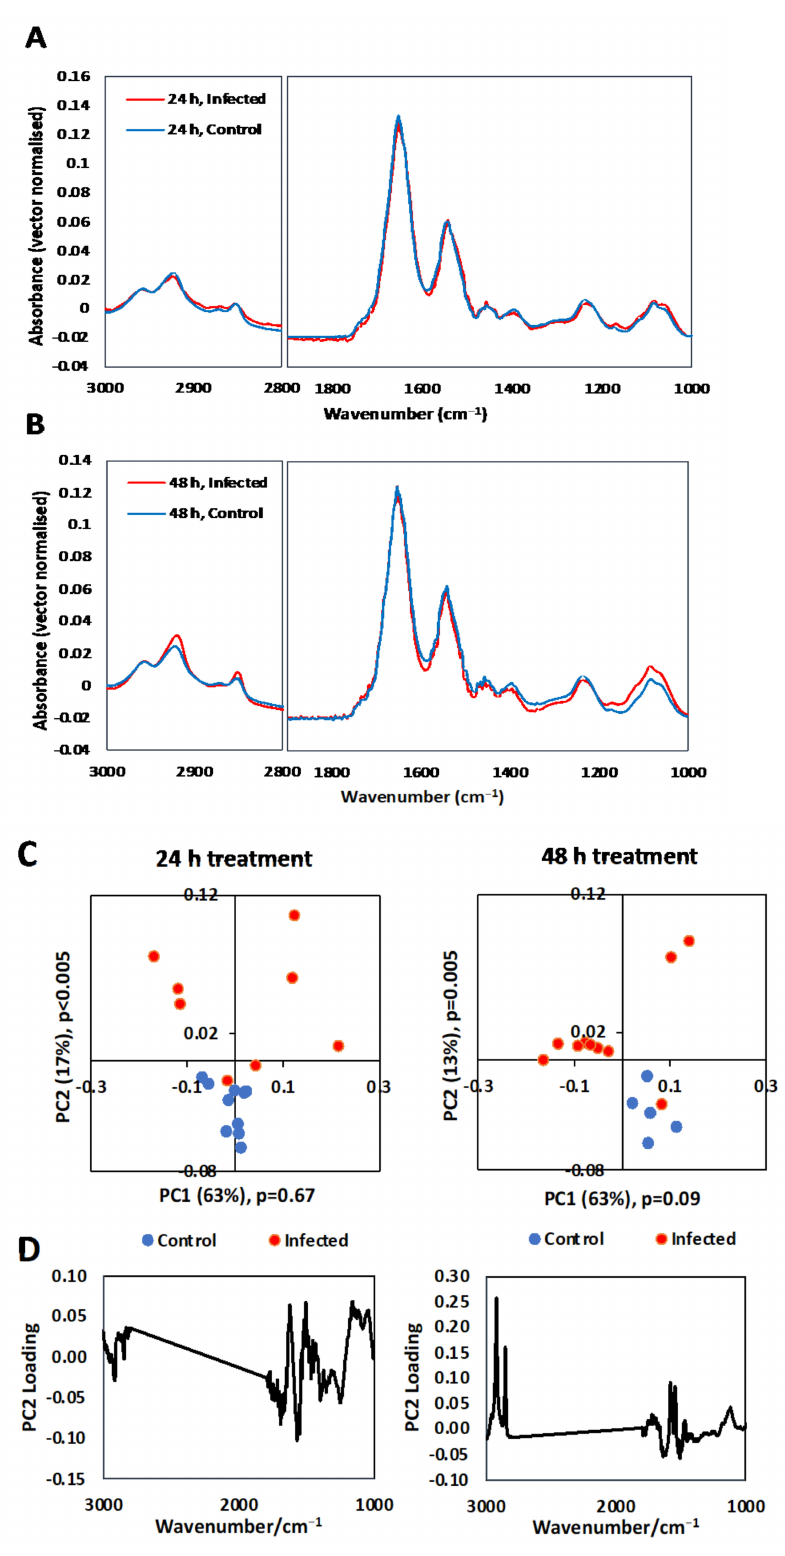
Figure 1. The averaged spectra of cells at 24 h ( A ) and 48 h ( B ) after treatment. Pair-wised (control versus infected) PCA of spectral data obtained from traditional FTIR microscopy at 24 h and 48 h after infection with ( C ) showing the score scatter plots and ( D ) showing the PC2 loading